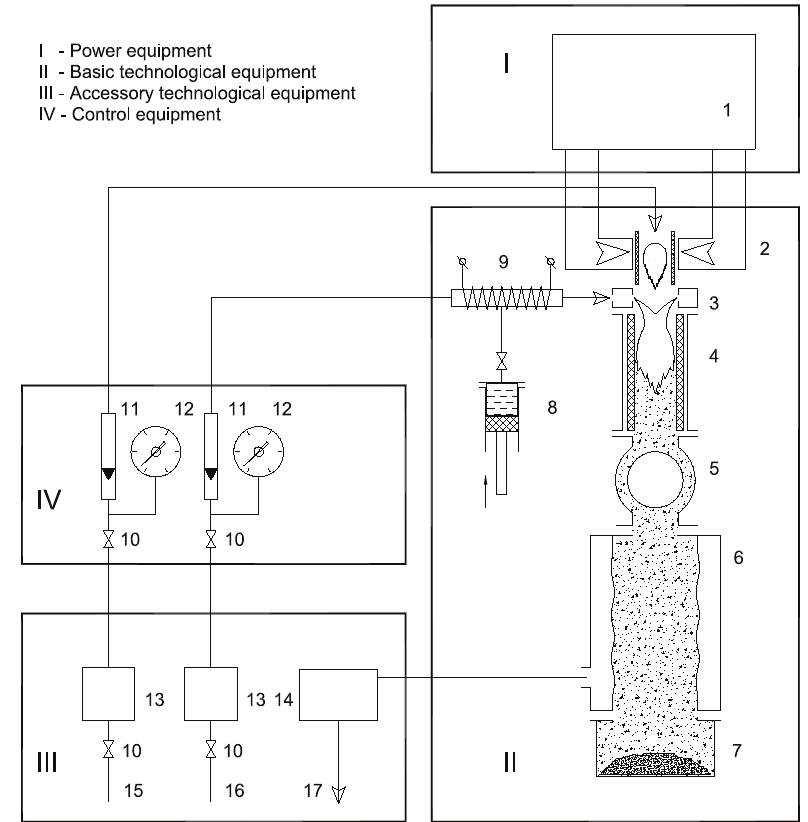
Figure 1. Schematic drawing of the microwave plasma process: (1) microwave generator; (2) plasmatron; (3) input attachment for precursor; (4) reactor; (5) heat exchanger; (6) filter; (7) powder collector; (8) dosing device for precursor; (9) evaporator; (10) valves; (11) rotameters; (12) manometers; (13) system for gas purification; (14) scrubber; (15) inlet of plasma forming gas; (16) inlet of gas carrier and (17) outlet of